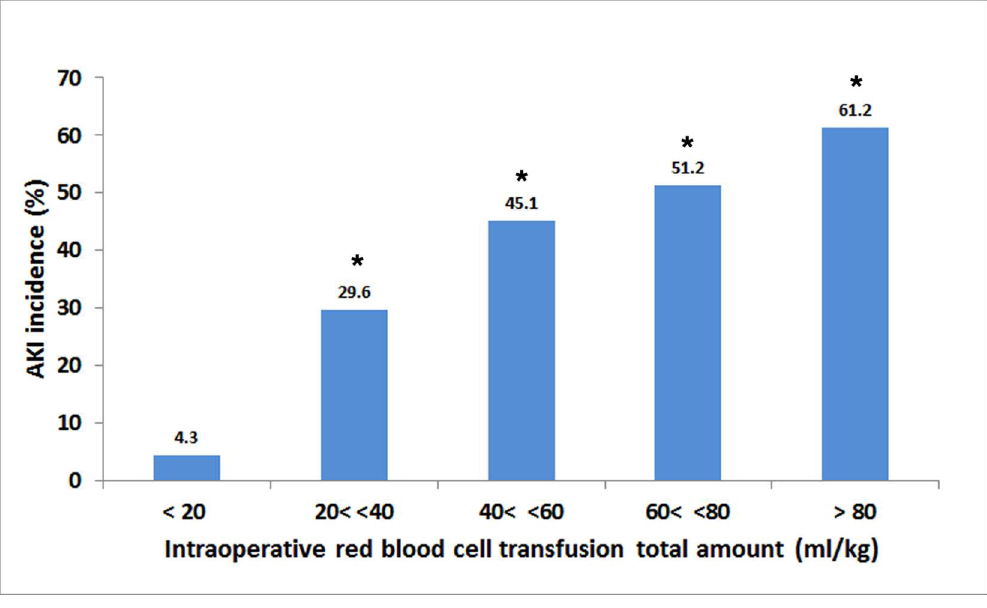
Fig 1. Incidences of postoperative acute kidney injury according to categorized total amount (mg/kg) of intraoperative red blood cell transfusion. * Significantlydifferent from the patients with intraoperative transfusion amount < 20